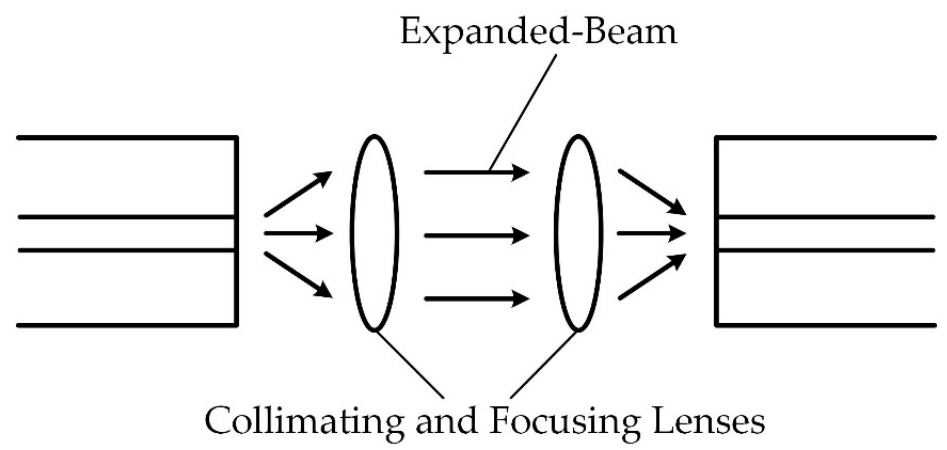
Figure 10. Schematic view of expanded-beam optical connection, and the lenses can be one integrated collimating/focusing lens.